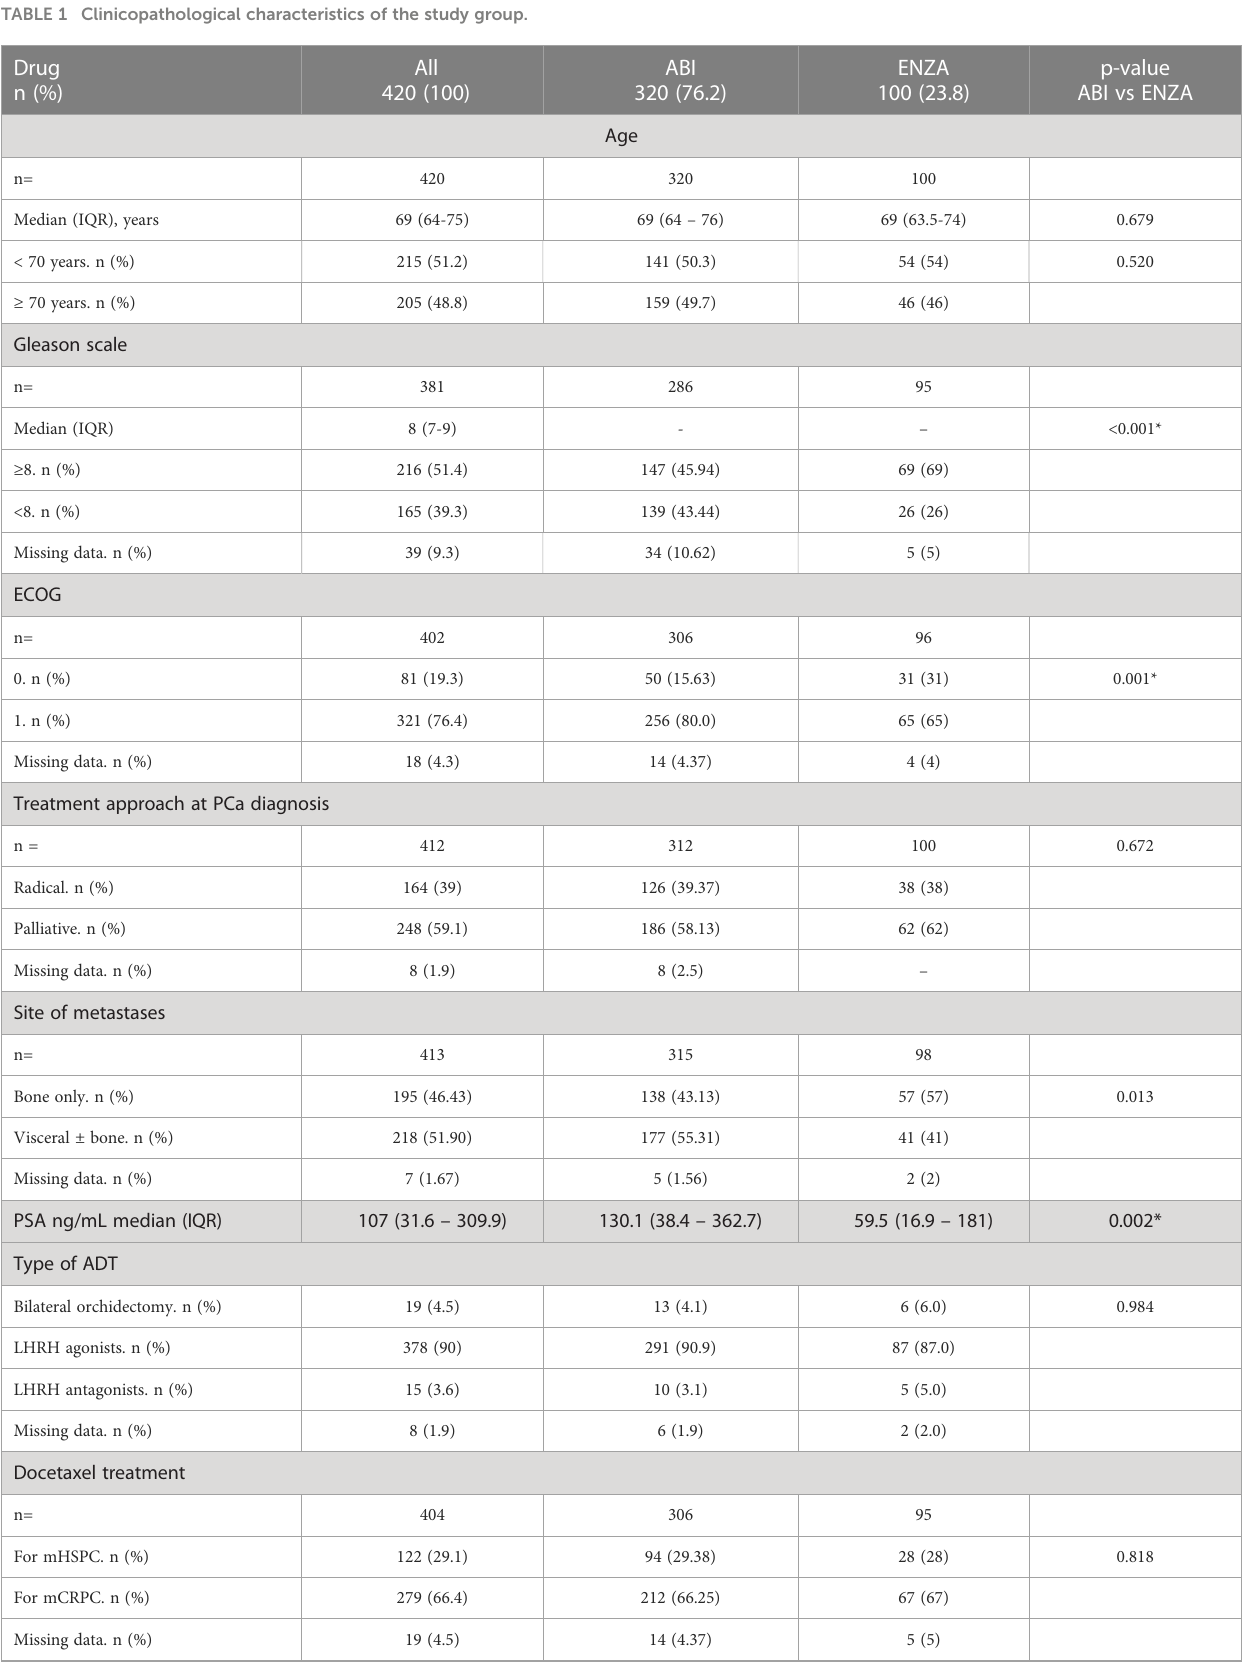
TABLE 1 Clinicopathological characteristics of the study